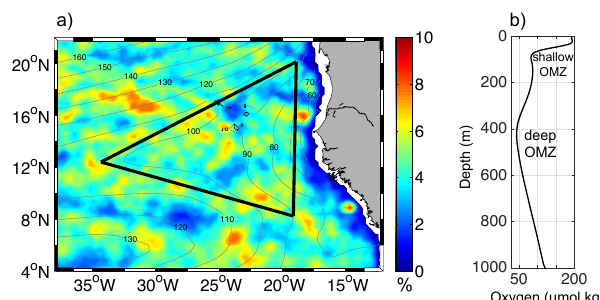
Figure 1. (a) Map of the ETNA including contour lines of the oxy- gen minimum of the upper 200m (inµmolkg − 1 ) as obtained from the MIMOC climatology (Schmidtko et al., 2013). The color indi- cates the percentage of “dead-zone” eddy coverage per year. The black triangle defines the SOMZ. (b) Mean vertical oxygen profile of all profiles within the SOMZ showing the shallow oxygen min- imum centered around 80m depth and the deep oxygen minimum centered at 450m